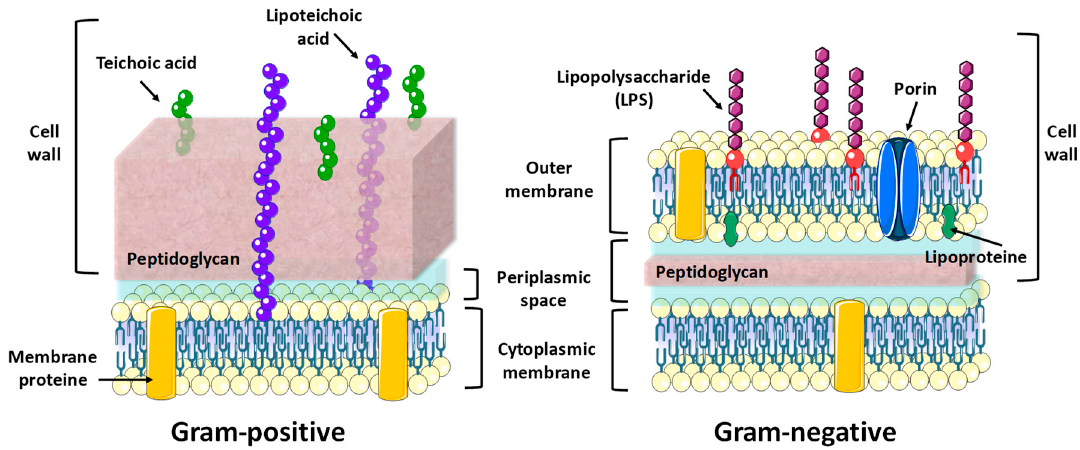
Figure 4. Comparison between structures and cell wall components of G + and G − bacteria. Build upon the material available in the website https://smart.servier.com.